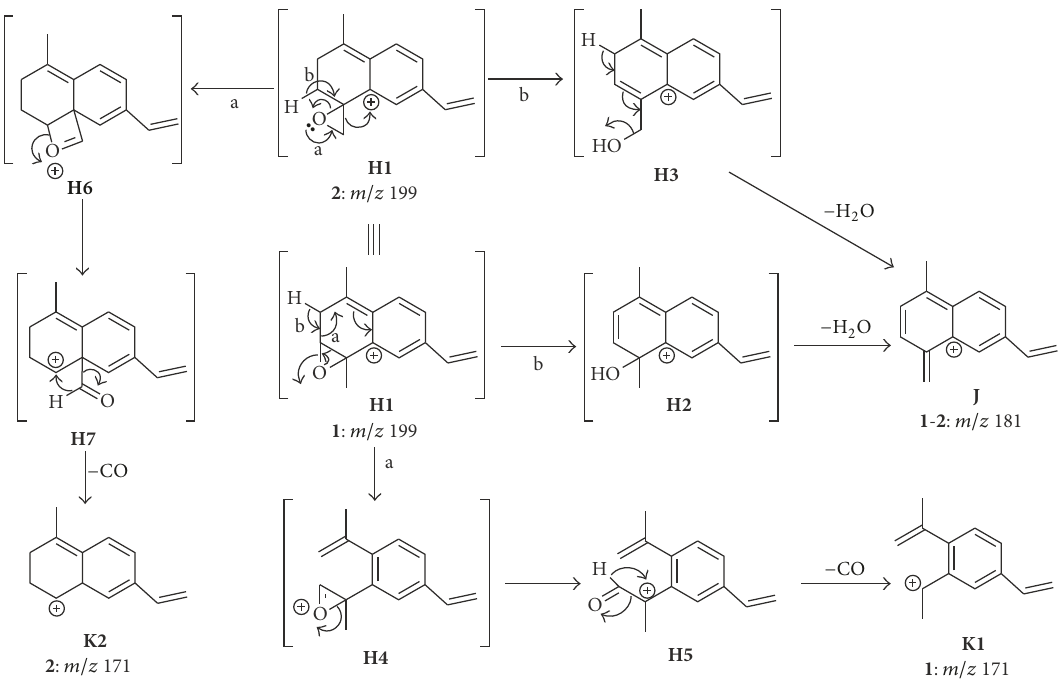
Scheme 3: Formation of the general fragment ions J and K for compounds 1 and